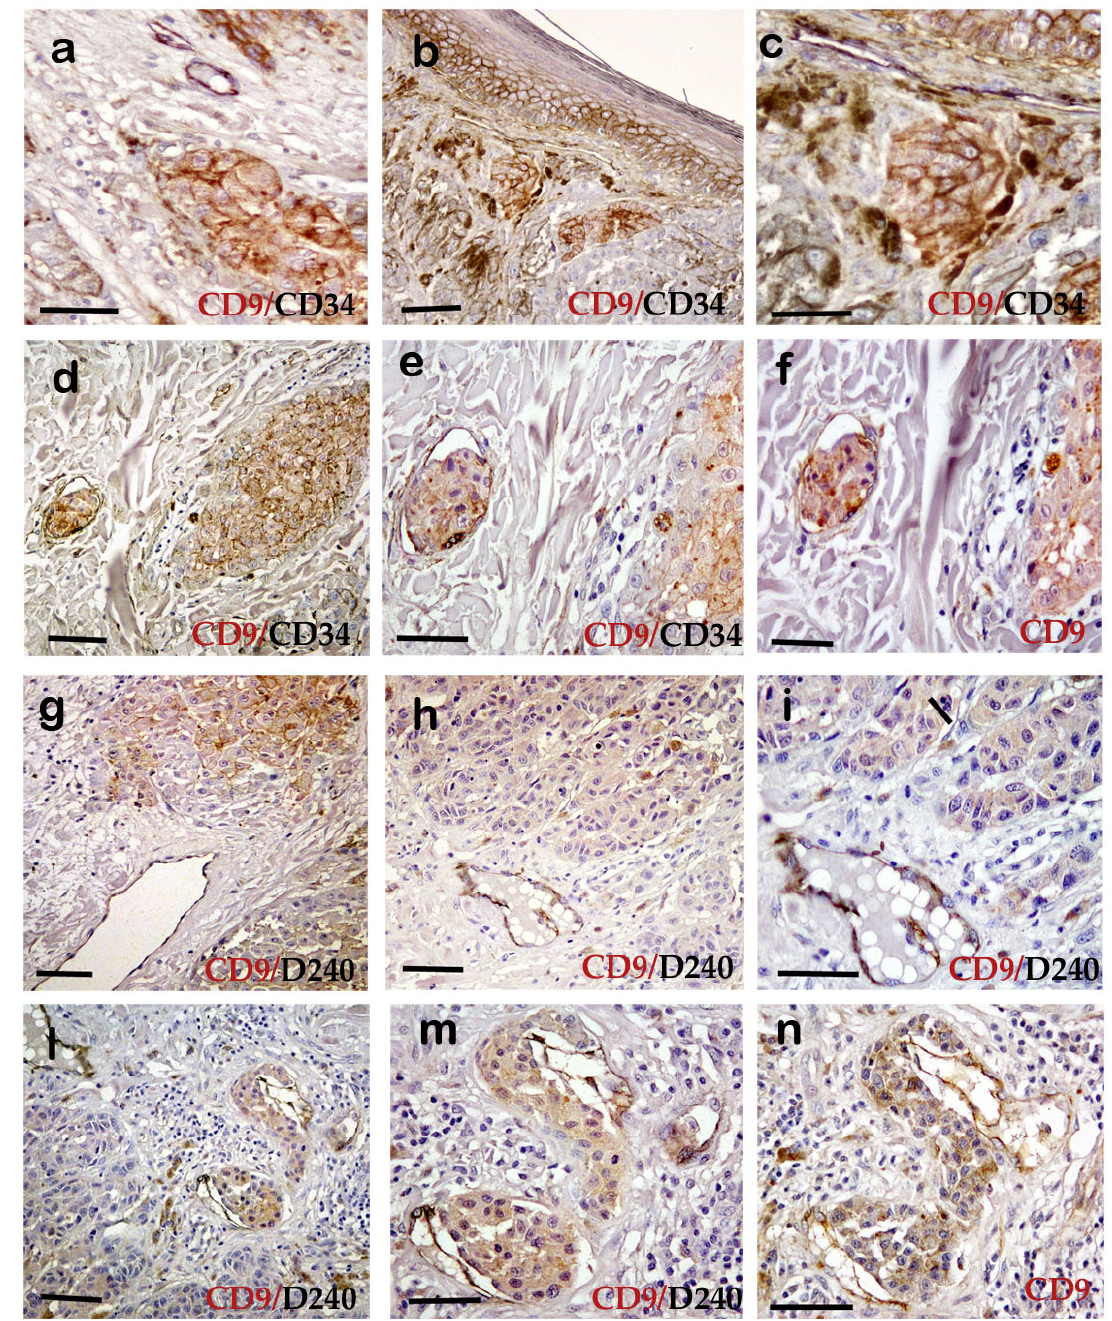
Figure 4. CD9 re-expression in positive tumor clusters near or inside blood and lymphatic vessels by immunohistochemical double staining. ( a – f ) Tumor melanocytic cells and blood vessels stained by CD9/CD34 double staining. ( g – i , l – n ) Tumor melanocytic cells and lymphatic vessels stained by CD9/D240 double staining. (immuno-peroxidase scale bars 50 µ).